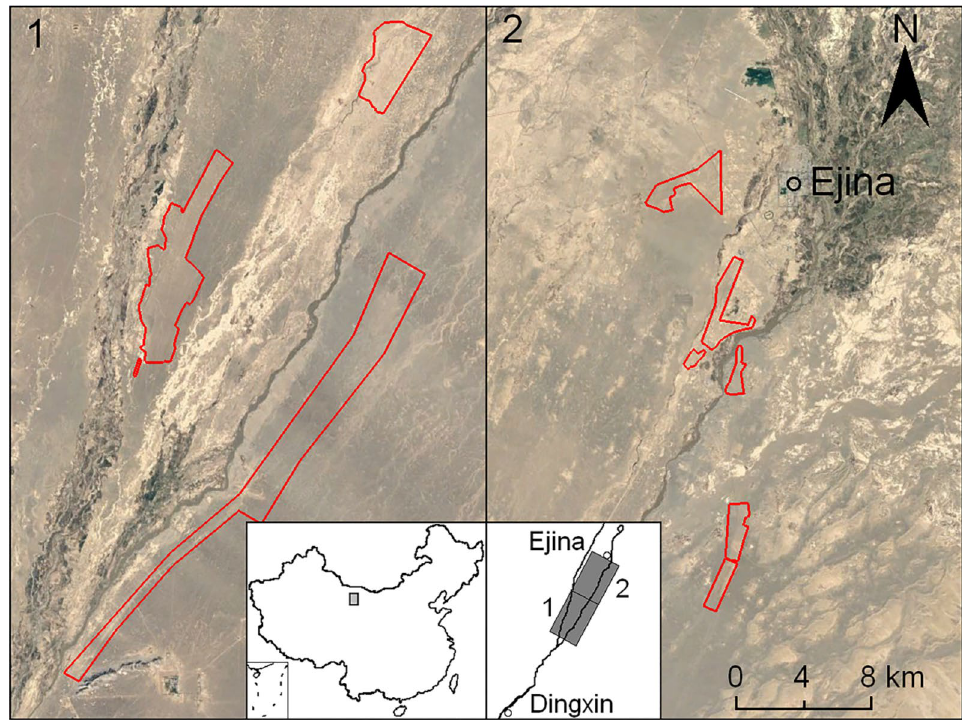
Figure 1. Satellite image of afforested area in the gobi region, Ejina Qi, Inner Mongolia, China. Red-lined areas indicate locations where shrubs ( Haloxylon ammodendron ) were planted. The maps were generated using ArcGIS software version 10.3 (https:// www. arcgis. com/ index. html) and insert satellite images are downloaded from Google Earth Pro software version 7.1.7.2606 (https:// www. google. com/ earth/ versi ons).